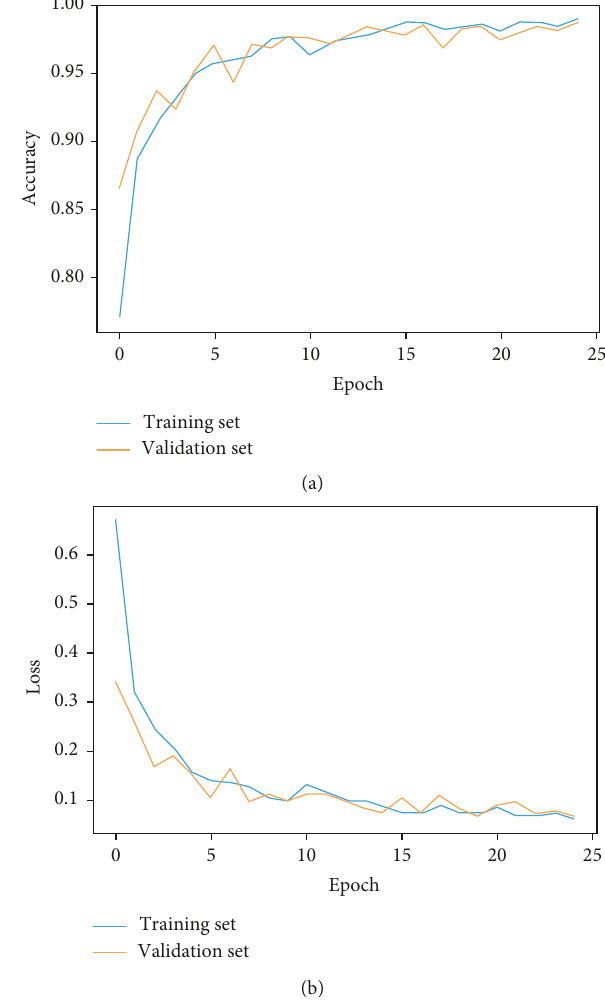
Figure 9: Training process of the recognition